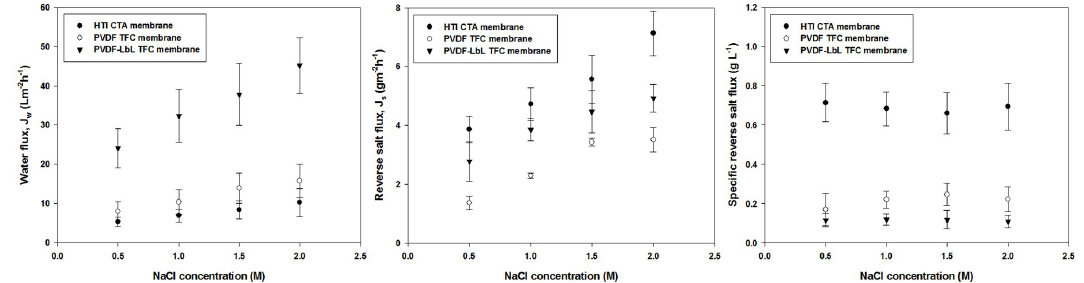
Figure 7. Membrane performance for FO operation of the PVDF TFC membrane, PVDF-LbL TFC membrane and commercial CTA membrane at different concentrations of NaCl (0.5–2.0 M) as draw solution and DI water as feed solution.